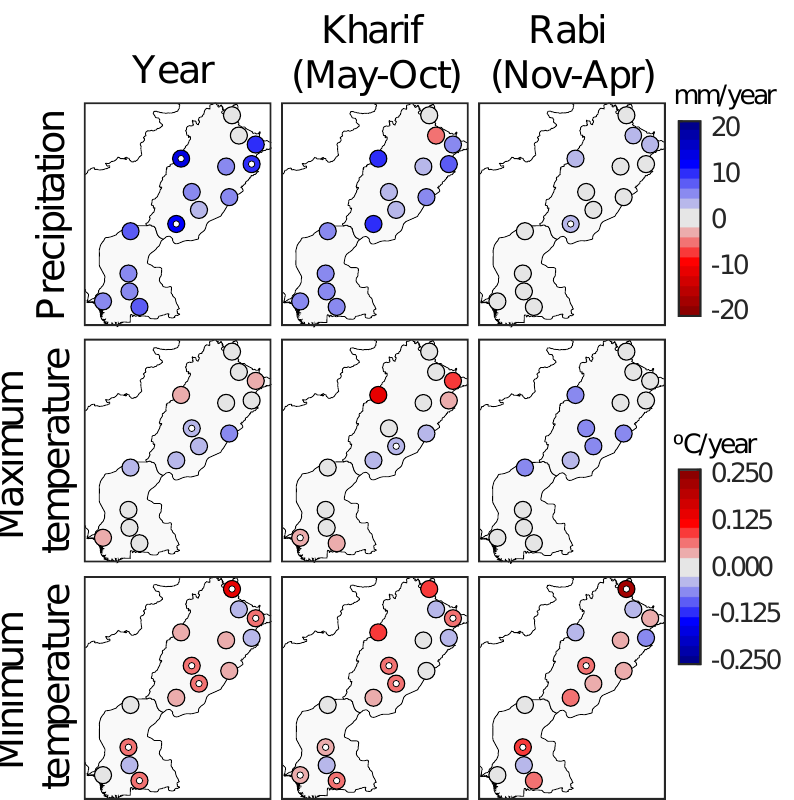
Figure 3. Observed annual trends in precipitation, maximum and minimum temperature (from top to bottom ) over the period 1997–2016 for the whole year and the Kharif and Rabi seasons (in columns). Significant (95% confidence level) trends are marked with a white dot.